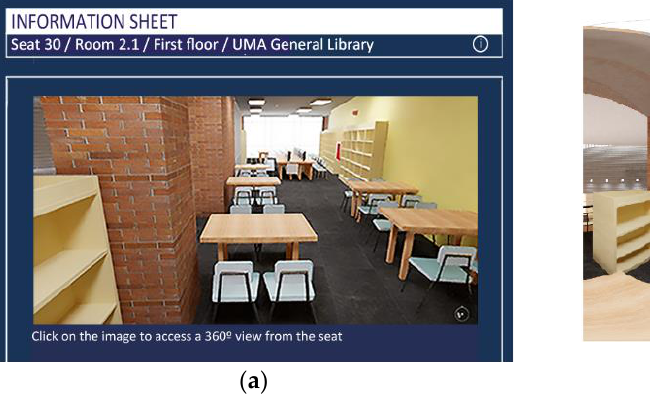
Figure 4. Link to the online 360- degree image viewer from the app’s query interface (Supplemen-